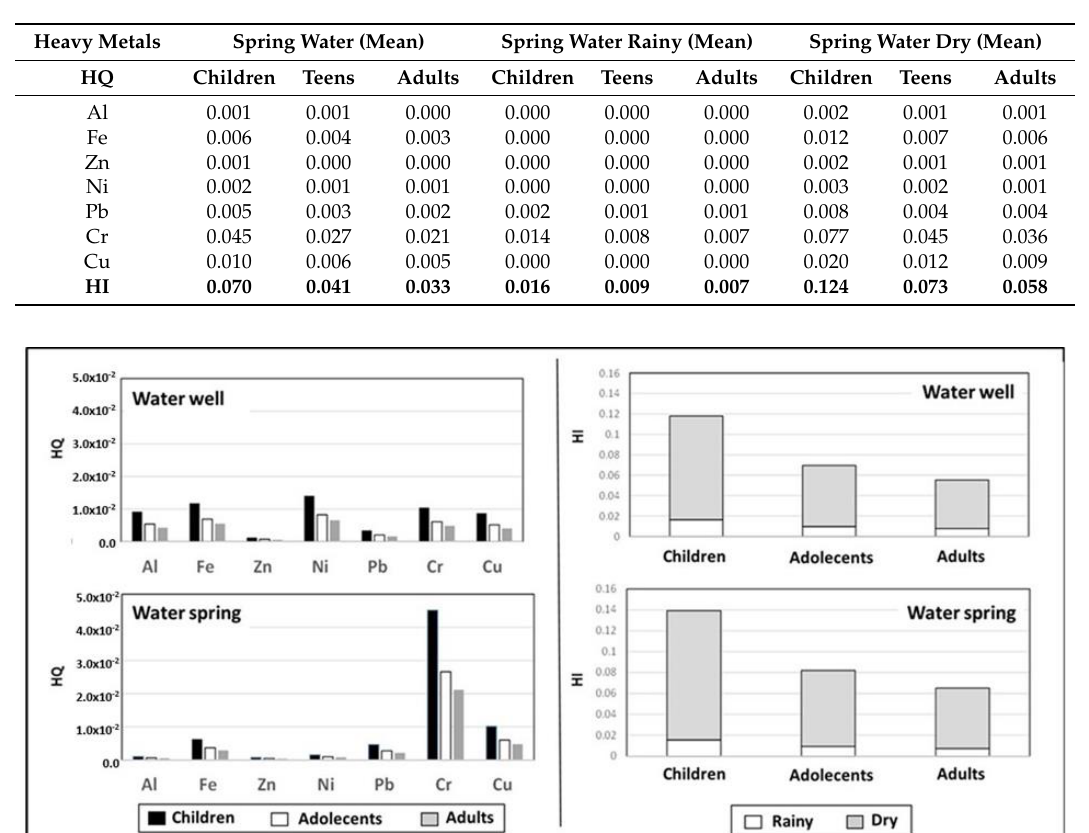
Table 5. Cancer risk index considering the individual and total effect of the potentially carcinogenic metals present at the spring W and the wells W., for the subpopulation of children, teenagers and adults of E. Portes Gil.